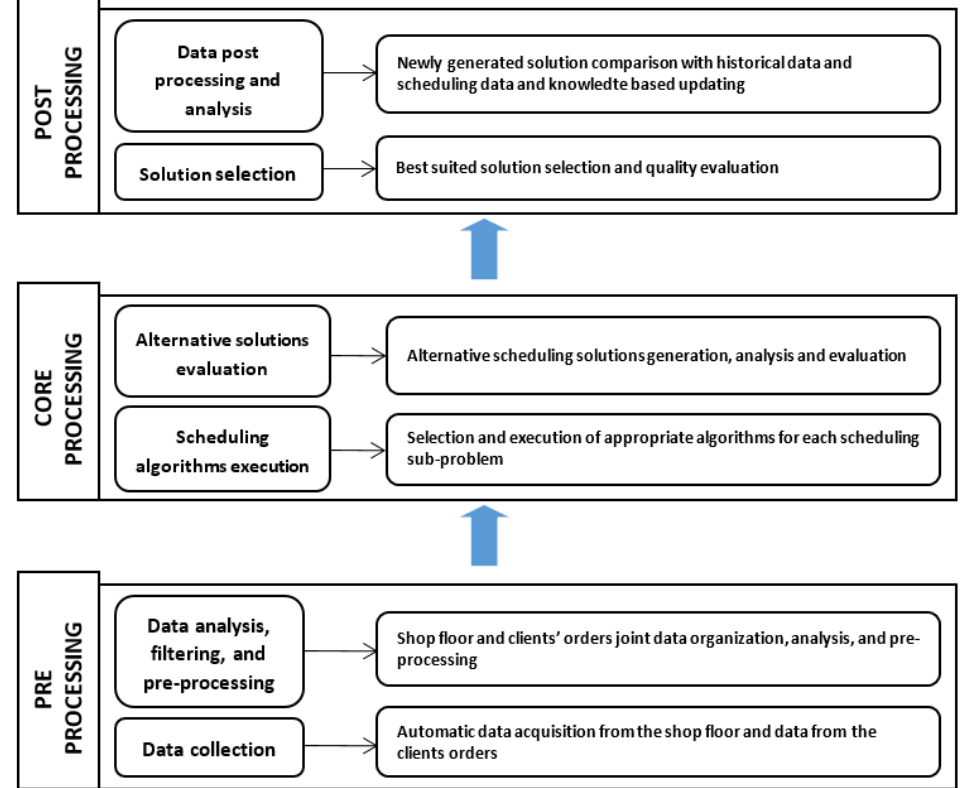
Figure 3. Scheduling framework.